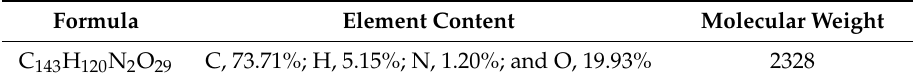
Figure 4. The plane structure model of the Bulianta coal. Table 6. Element composition and density of the Bulianta coal models.